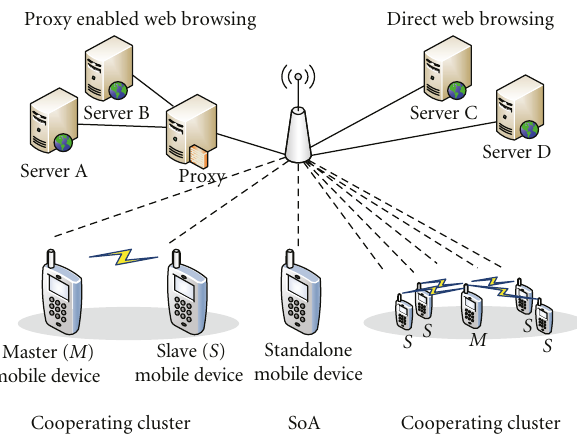
Figure 6: Architecture for noncooperative and cooperative web browsing with direct or proxy enabled Internet